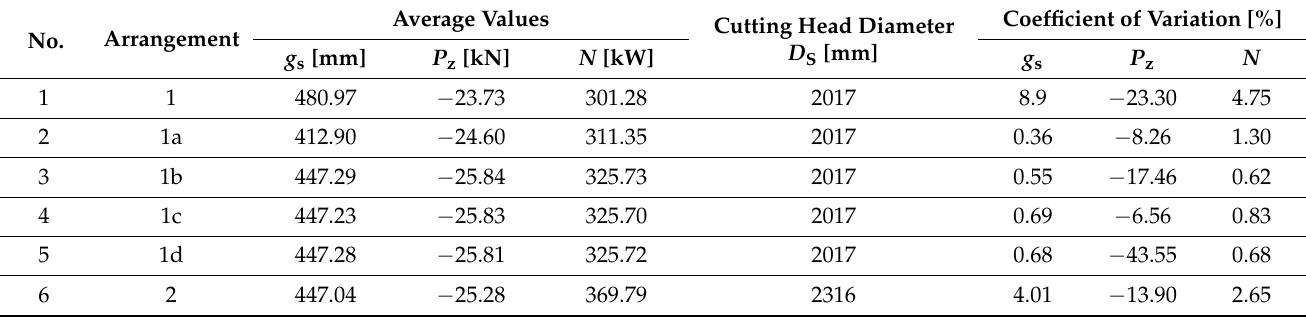
Figure 17. Waveform of the values of power N and cutting head impact force in the direction of shearer’s advance P z for pick arrangement 2. Table 3. Summary of average values of power N and force P z for various pick